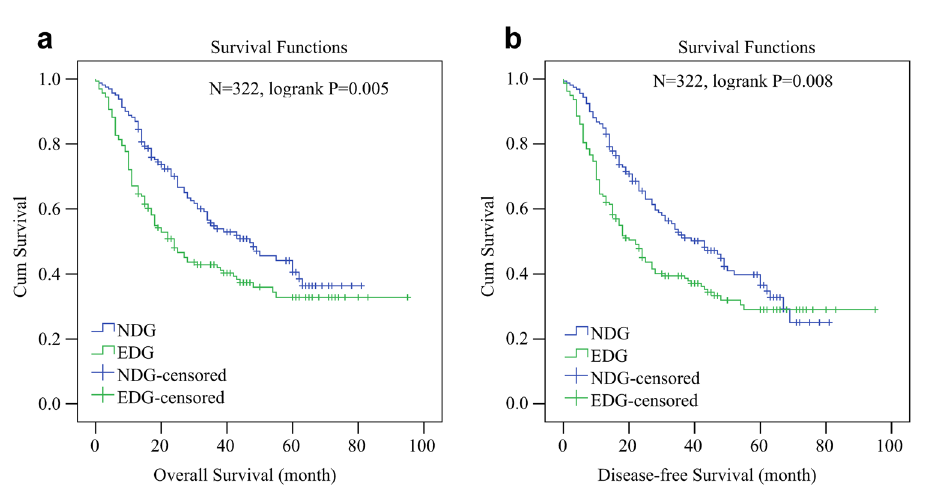
Figure 3. Kaplan–Meier (KM) survival curves for matched GC patient series who underwent radical gastrectomy (N = 322). ( a ) the 5-year overall survival rate was 40.6% for NDG and 32.8% for EDG (P = 0.005). ( b ) the 5-year disease-free survival rate was 36.6% for NDG and 29% for EDG (P =